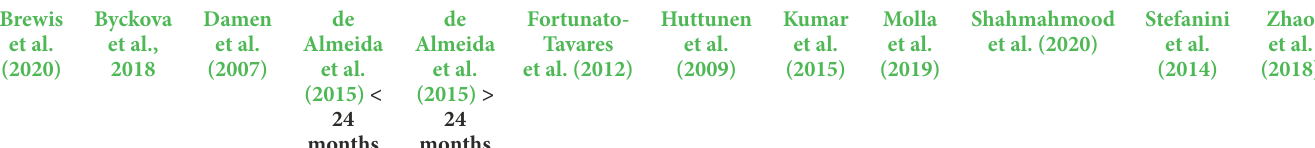
TABLE 10 Supporting the child subscale Tukey HSD post-hoc mean